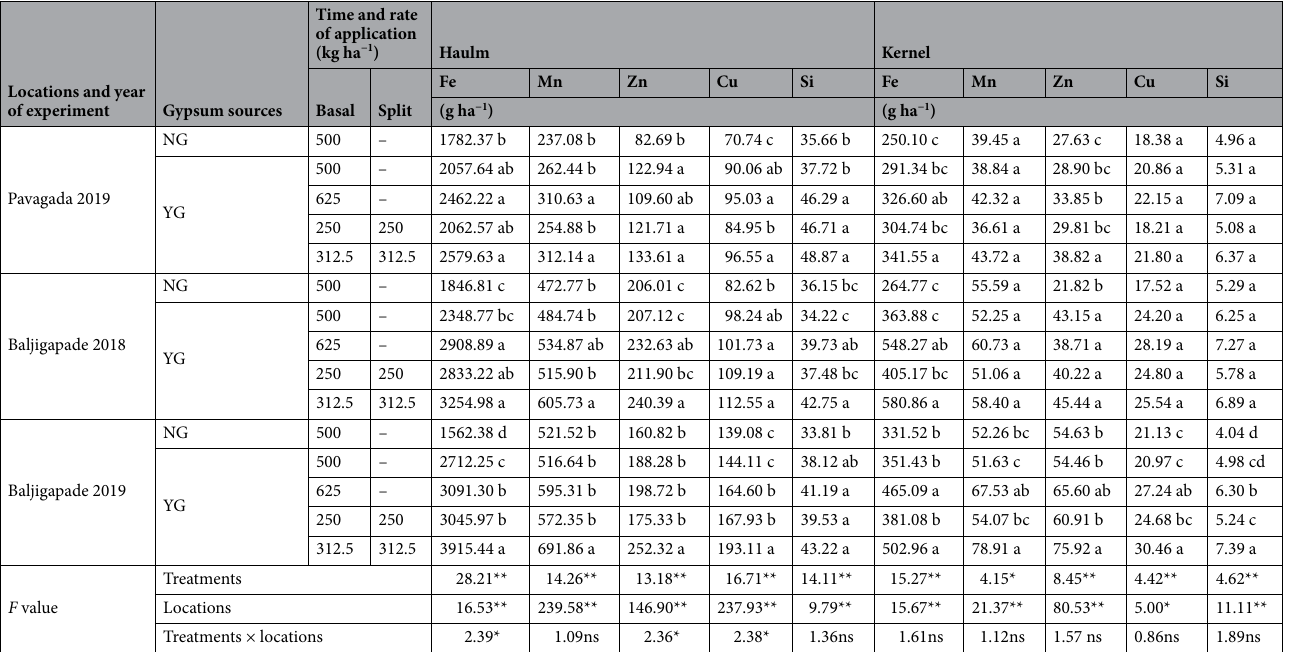
Table 5. Effect of different sources, time and rate of application of gypsum on uptake of micronutrients and silicon by haulm and kernel of groundnut at harvest. F value and significance level (**P < 0.01, *P < 0.05 and ns P ≥ 0.05). Values followed by a different letter within the same column and the same year are significantly different at P < 0.05 probability level. YG yellow gypsum, NG natural